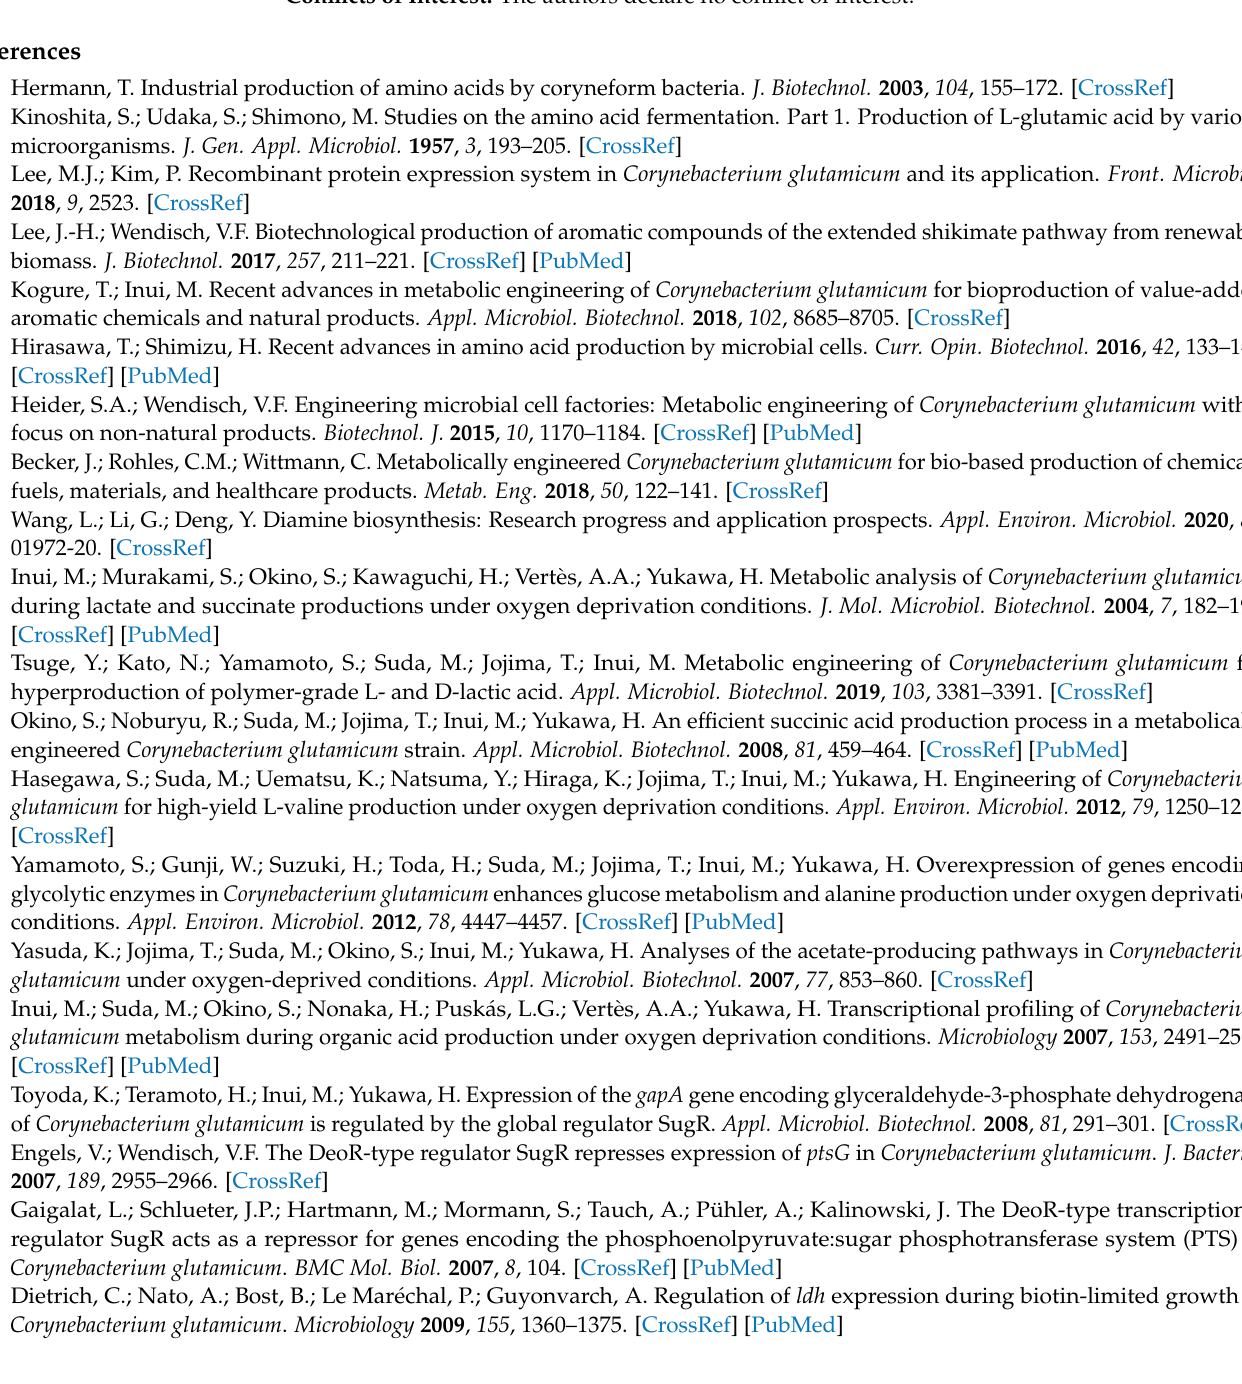
Table S2: oligonucleotide primers used in this